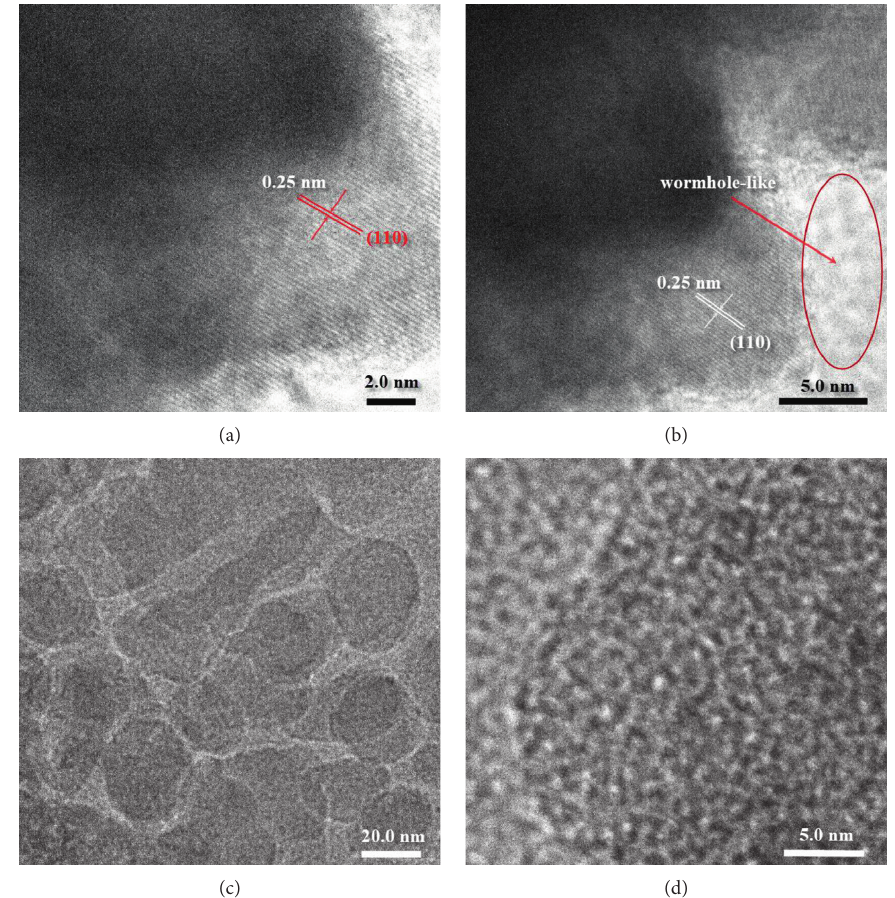
Figure 9: HR-TEM images of iron (III) benzene dicarboxylate samples synthesized at 150 ° C and 24h with different Fe (III)/BDC molar ratios: (a), (b) 1:1; (c), (d) 1: